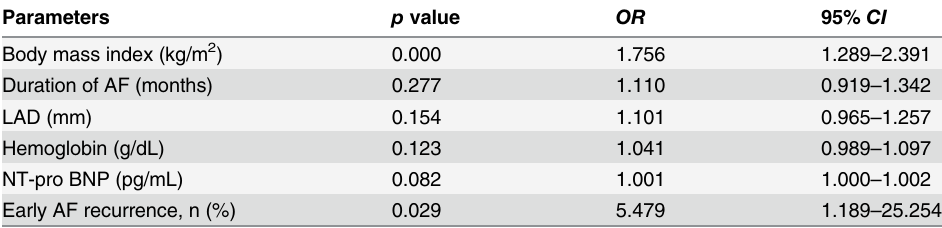
Table 3. Multivariate analysis the relating risk factors for late AF